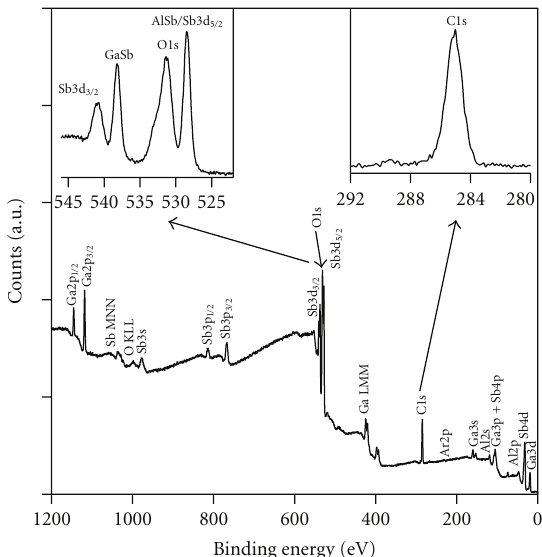
Figure 5: XPS wide scan obtained at the surface of Al 0 . 05 Ga 0 . 95 Sb grown at 600 ◦ C with a V/III ratio of